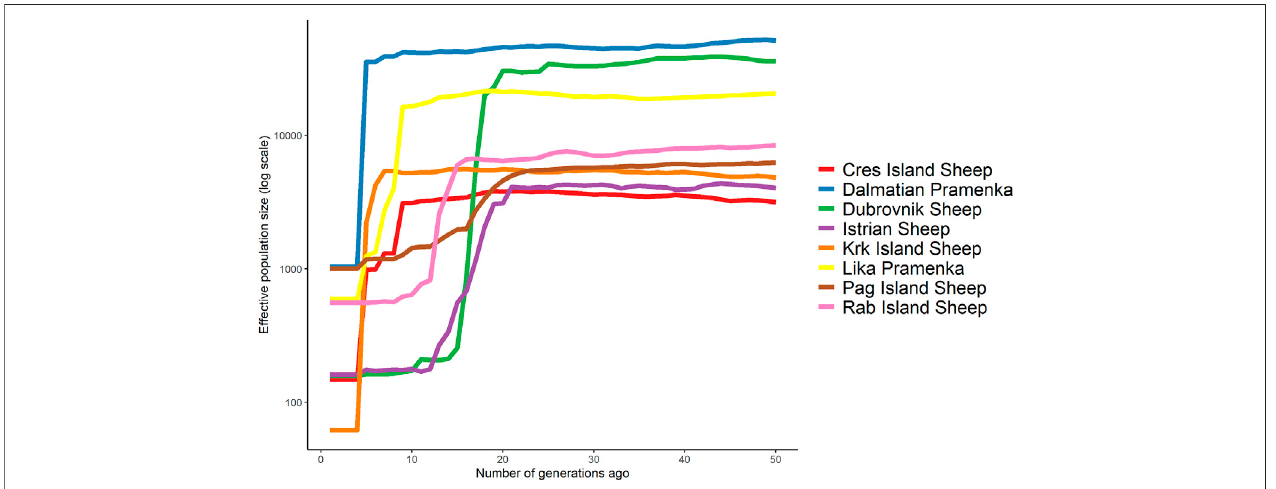
FIGURE 5 | Historical effective population size calculated with the software GONE for native Croatian sheep breeds during 50